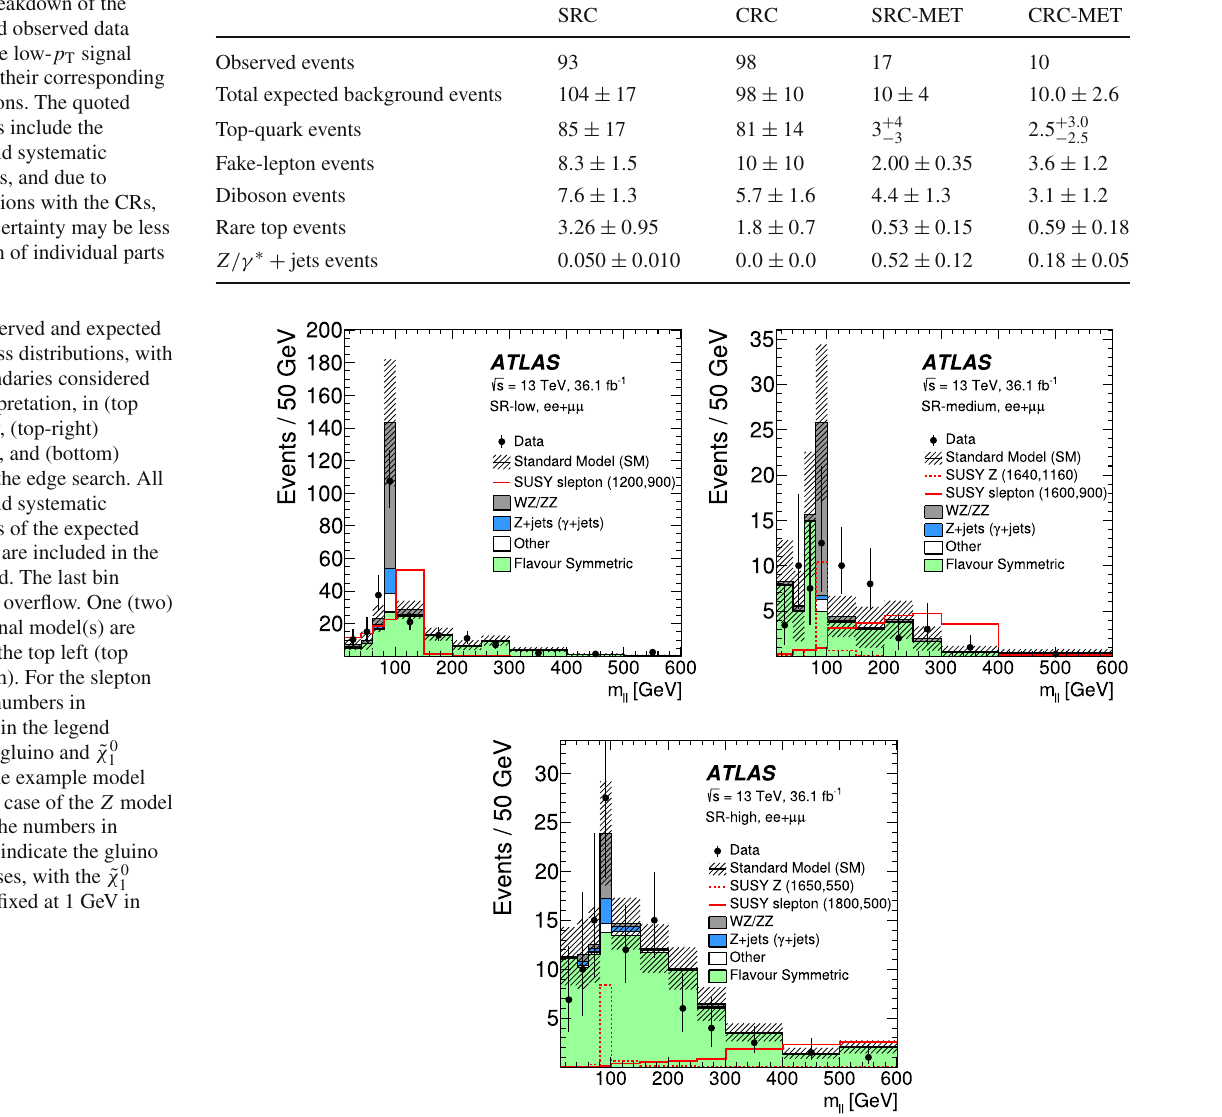
purity in Z Z production. The yields and kinematic distri- Table 4, are used to check the modelling of these processes at low lepton p T , and good modelling is also observed. Figure 8 shows the level of agreement between data and prediction in these validation